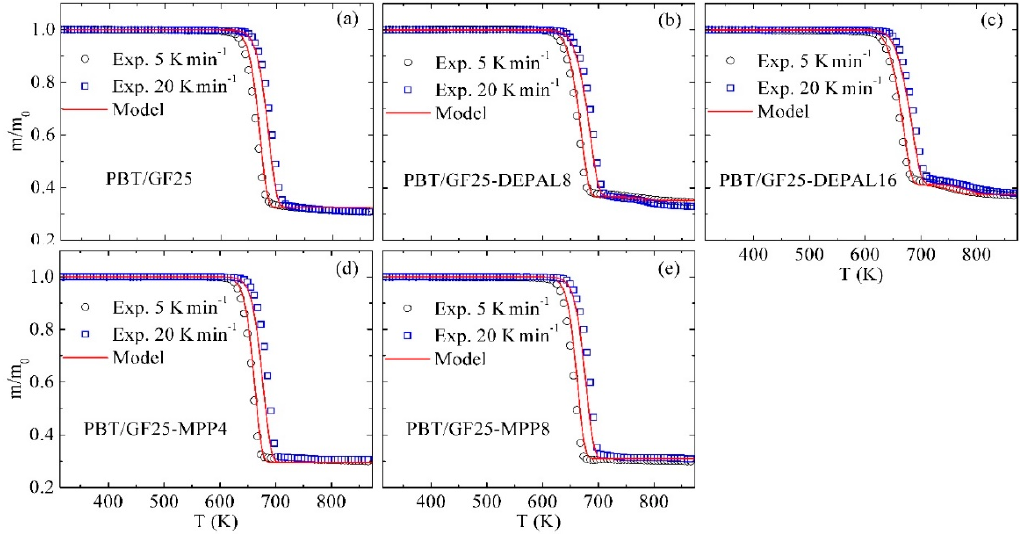
Figure 6. Experimental and simulated TGA data obtained for ( a ) PBT/GF25, (b) PBT/GF25-DEPAL8, ( c ) PBT/GF25-DEPAL16, ( d ) PBT/GF25-MPP4, and ( e ) PBT/GF25-MPP8 blends at 5 K · min − 1 and 20 K · min − 1 .